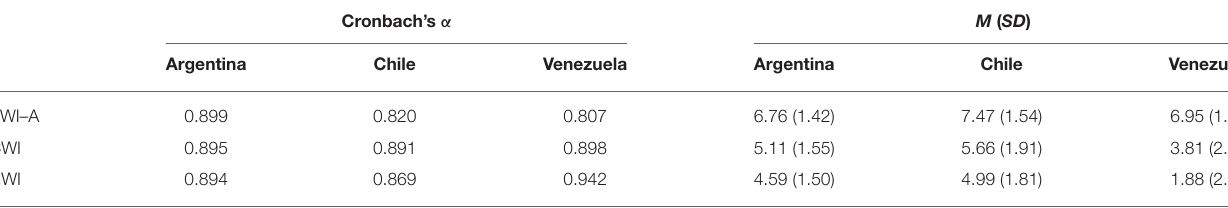
TABLE 1 | Descriptive statistics and differences between